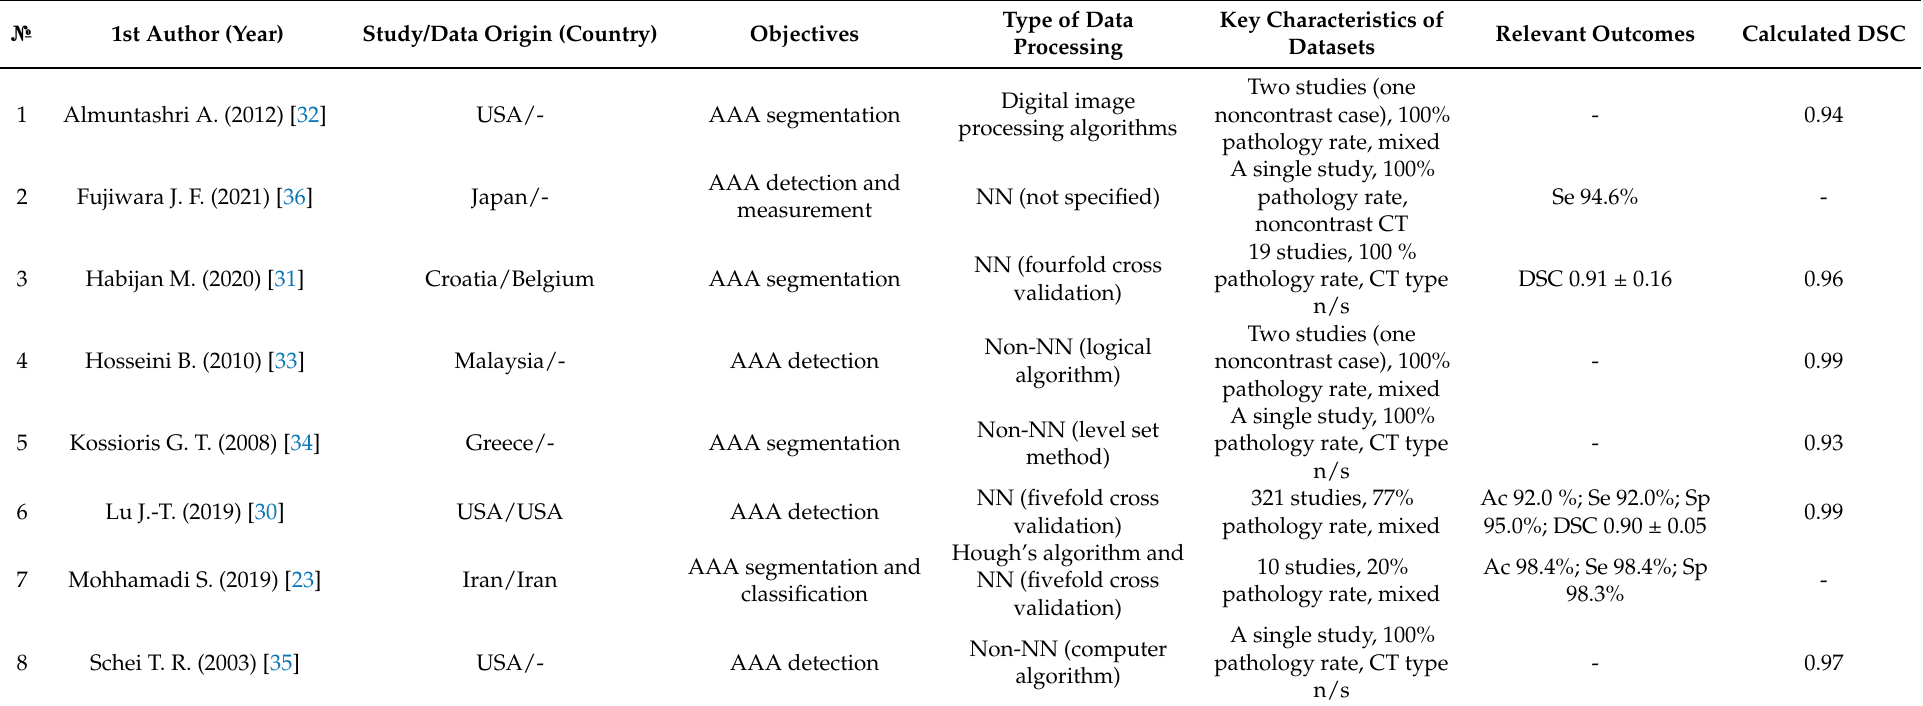
Table 1. Key characteristics of the studies 1